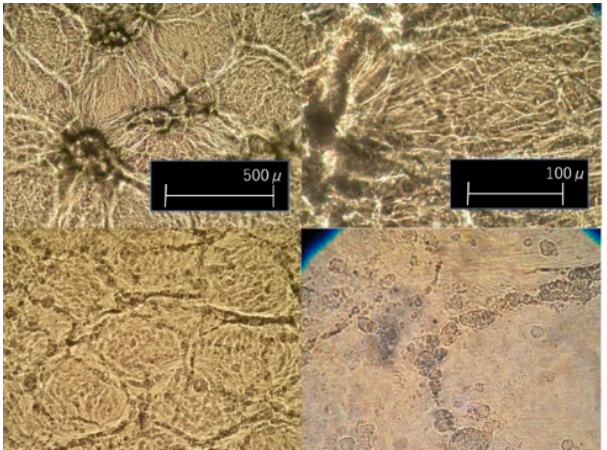
Figure 9. Optical micrographs of simultaneously biaxially stretched films at stretching speed of 1 m/min, DR = 4 × 4. ( upper ) 140 °C ( lower ) 130 °C.